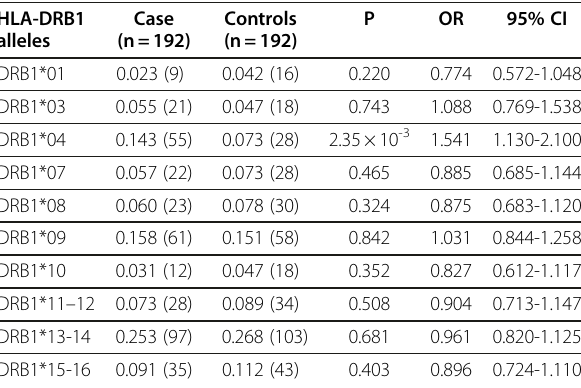
Table 2 A comparison of the frequencies of HLA-DRB1 alleles in primary IgAN patients and healthy controls from the Sichuan cohort